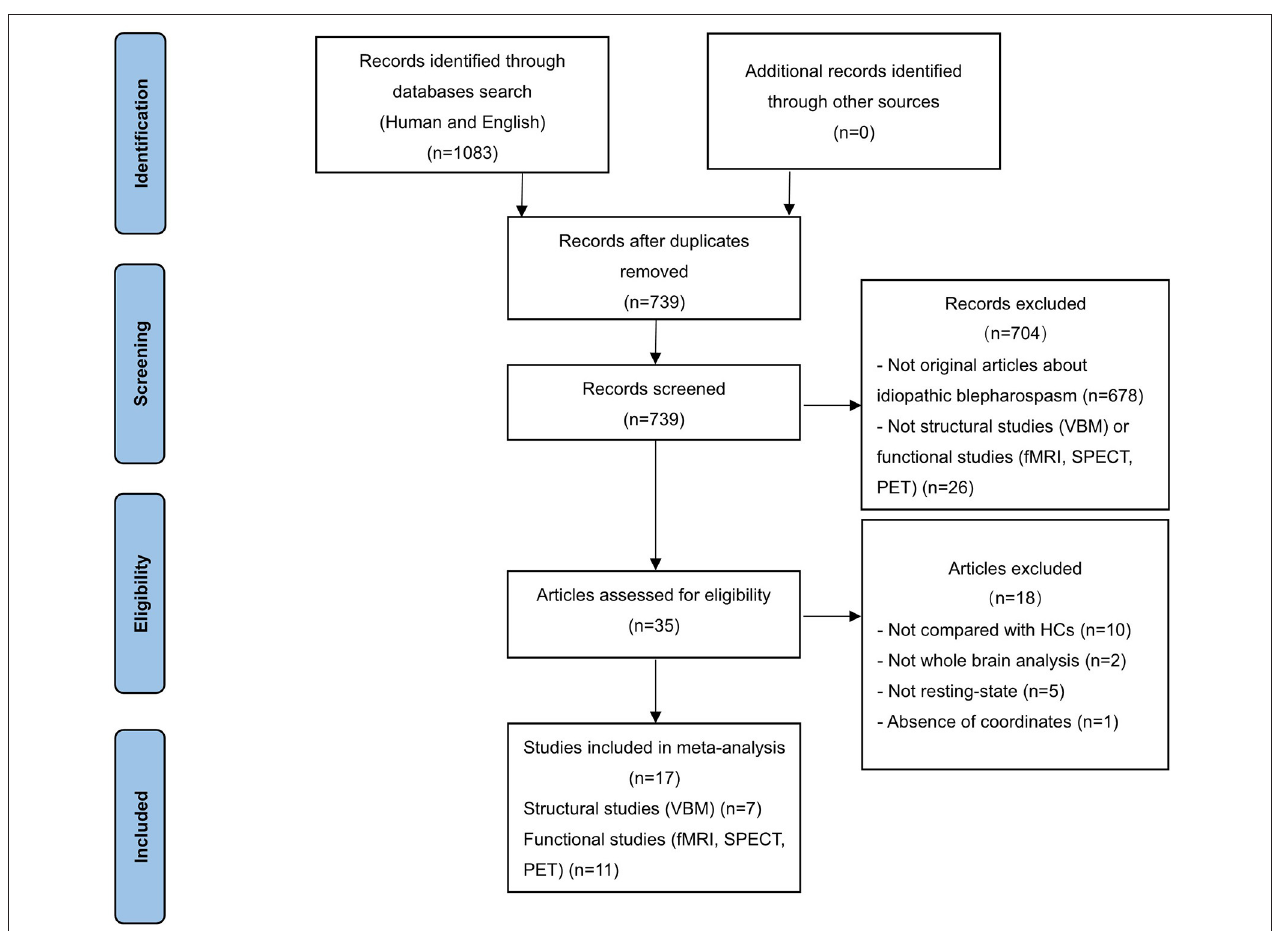
FIGURE 1 | PRISMA flow diagram representing selection procedure in